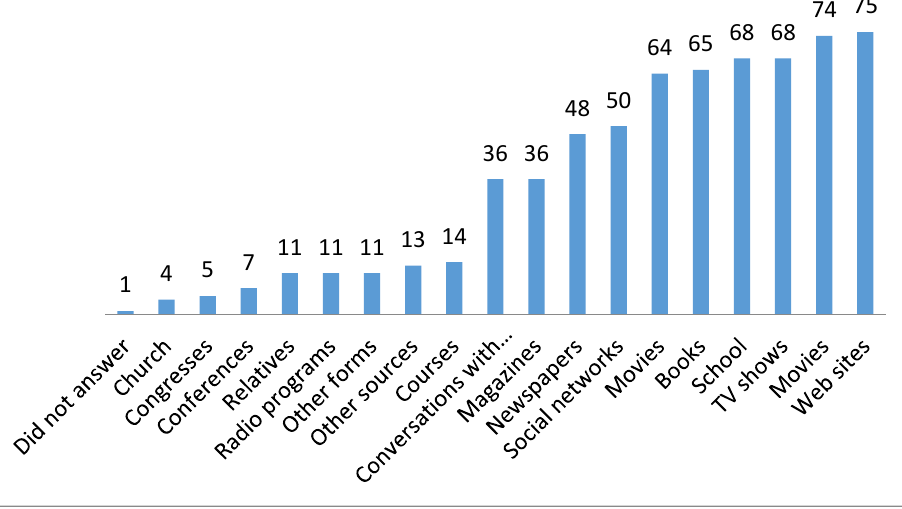
Table 3: Four-house chart showing the social representations of Astronomy elaborated by the students surveyed.